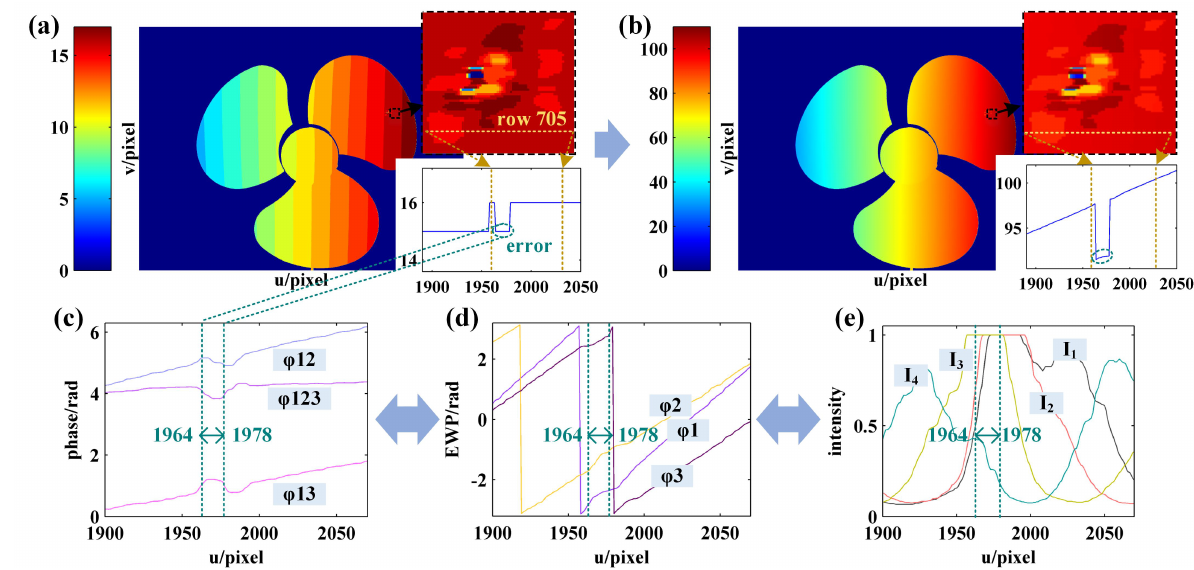
Figure 18. Phase unwrapping results of the three-blade fan obtained by three-frequency phase-shift method: ( a ) fringe order map; ( b ) absolute phase map; ( c – e ) are the equivalent phase, EWP, and sinusoidal fringe of row 705, respectively.